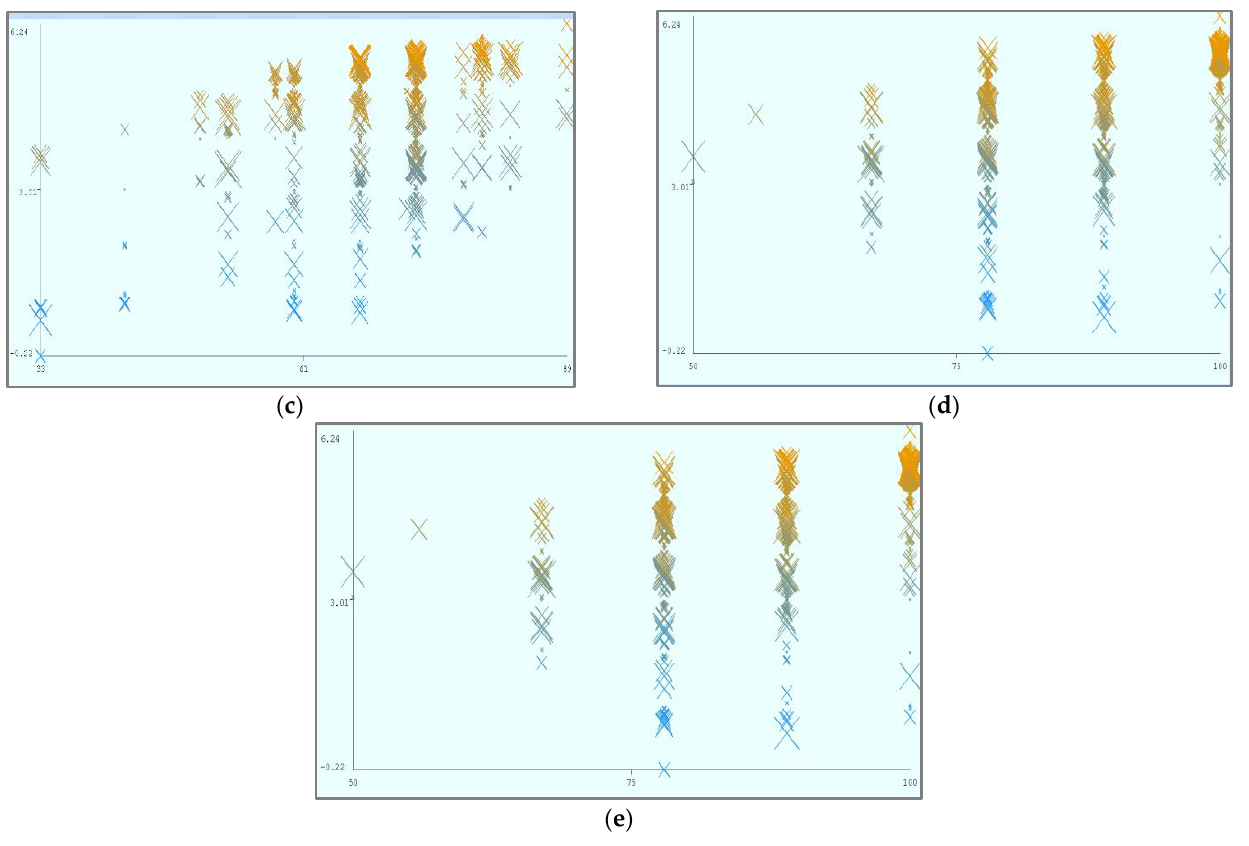
Figure 10. ( a ). Sequential minimal optimization regression error (X: Availability vs. Y: Predicted Ranking). ( b ). Sequential minimal optimization regression error (X: Security vs. Y: Predicted Ranking). ( c ). Sequential minimal optimization regression error (X: Reliability vs. Y: Predicted Ranking. ( d ). Sequential minimal optimization regression error (X: Cost vs. Y: Predicted Ranking). ( e ). Sequential minimal optimization regression error (X: Ranking vs. Y: Predicted Ranking).